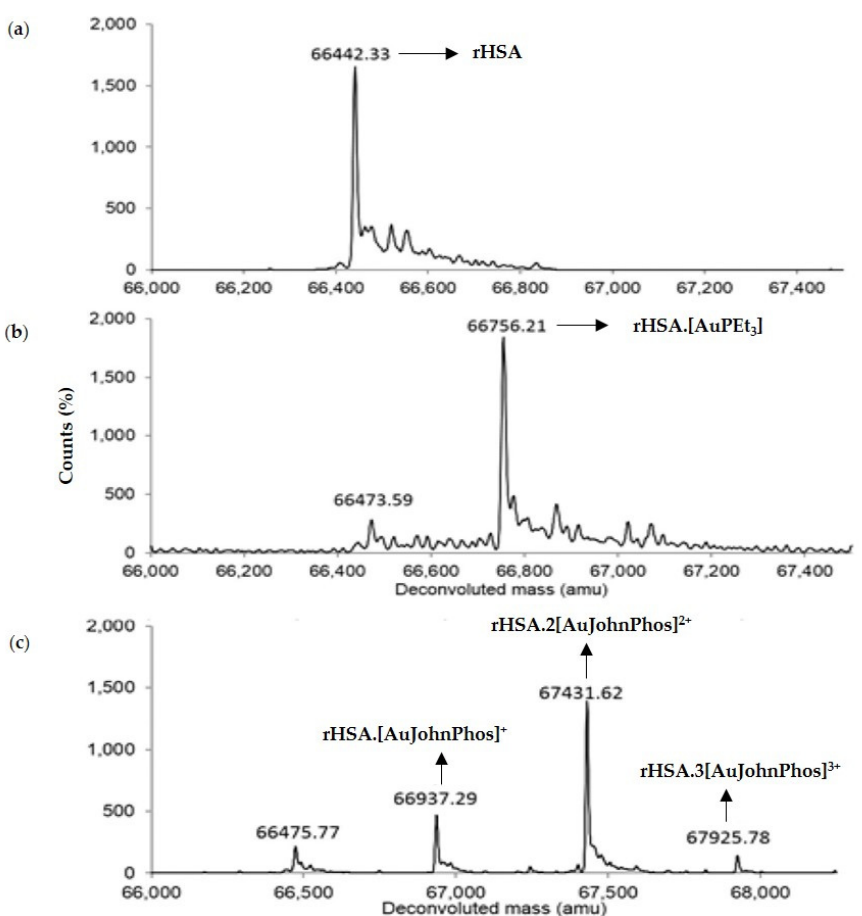
Figure 13. The ESI ‐ TOF MS of free HSA ( a ) and HSA reacted with 1.33 equiv. of [AuPEt 3 ] + ( b ) and 1.75 equiv of [Au(JohnPhos)] ( c ) [107]. Adapted with permission from Dean, T.C.; Yang, M.; Liu, M.;